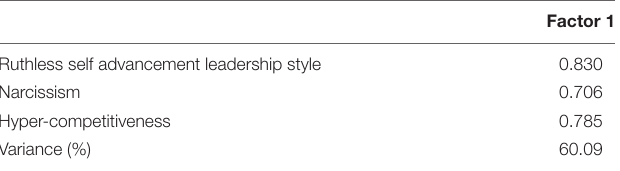
TABLE 3 | Factor loadings for antisocial leadership style